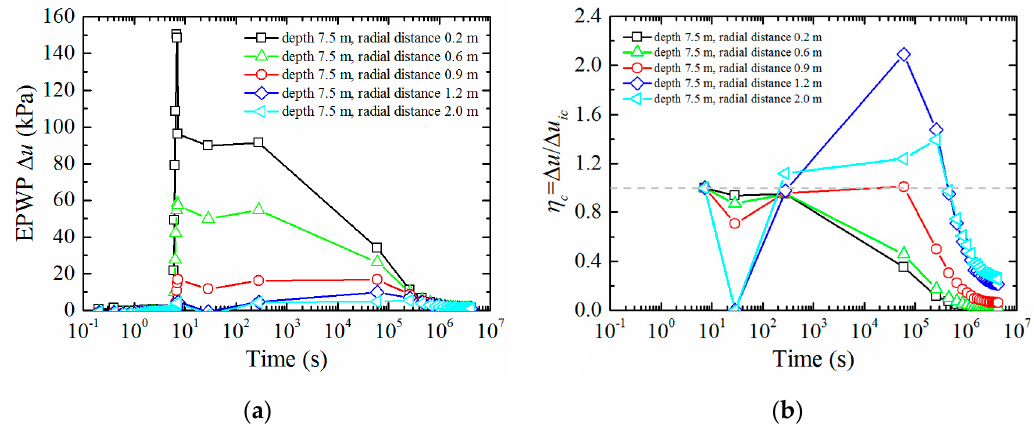
Figure 9. ( a ) Development and dissipation of EPWPs during and after pile installation at different distances from the pile wall; ( b ) Dissipation of normalized EPWPs after installation at different distances from the pile wall.